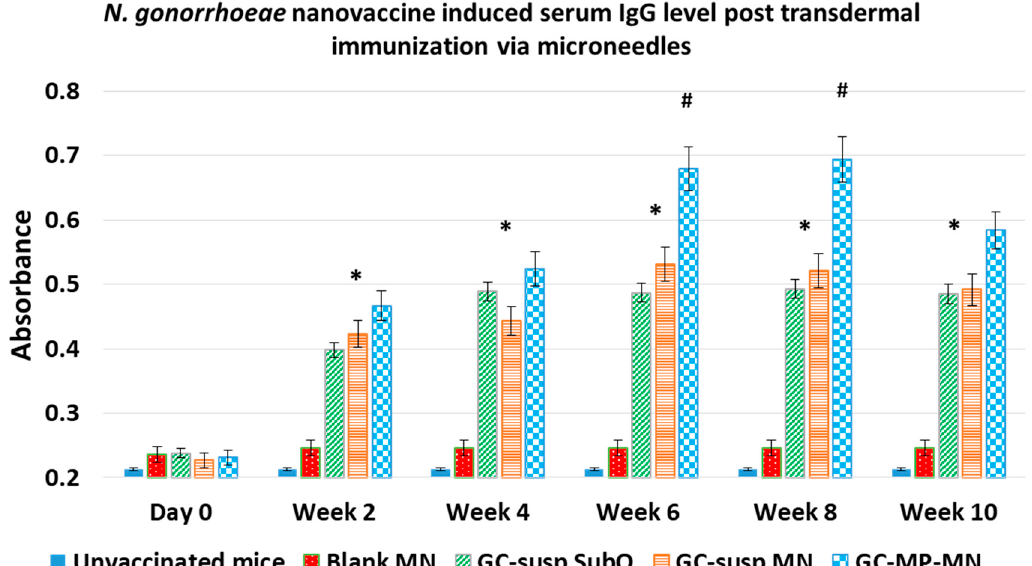
Figure 6. N. gonorrhoeae -specific antibody measurement in mice serum immunized transdermally using microneedles patch. Mice were vaccinated at day 0 followed by two booster at week 1 and 2 and immune response was monitored for 10 weeks. ELISA method was used to measure induced serum IgG levels in vaccinated mice and control groups. The groups receiving vaccine showed significantly higher serum IgG titers when compared to the controls i.e., blank microparticles and blank microneedles (MN) after week 2. The group which received the gonorrhea vaccine microparticles in microneedles (GC-MP-MN) showed significantly higher antibody titers than the other 2 vaccine groups at week 6 and 8 ( n = 6) (* p < 0.001; # p < 0.05). GC-susp SubQ: N. gonorrhoeae antigen in suspension administered subcutaneously (GC-susp SubQ); GC-susp MN: N. gonorrhoeae antigen in suspension administered transdermal via microneedle; GC-MP-MN: N. gonorrhoeae antigen loaded in nanoparticles administered transdermal via microneedles.